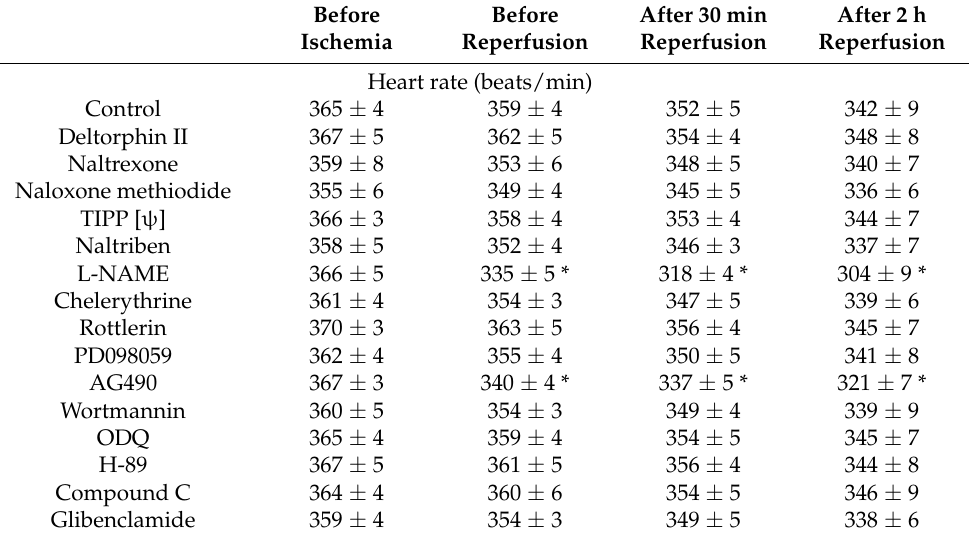
Table 1. Hemodynamics